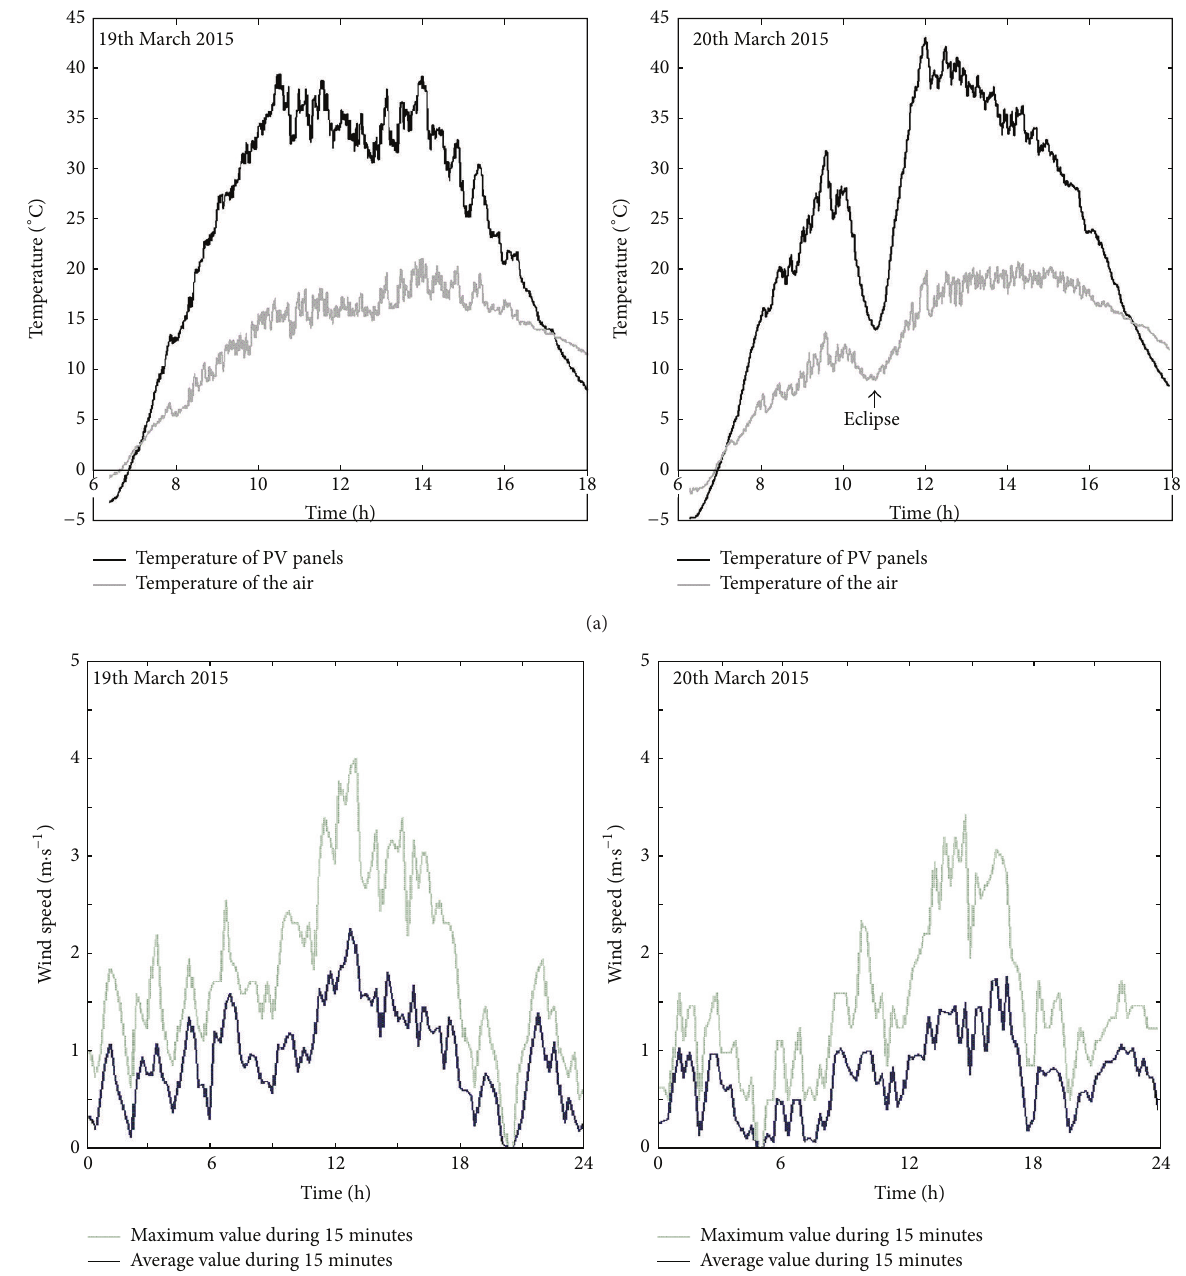
Figure 4: (a) Time series of PV panels temperature and air temperature and (b) time series of wind speed, during two sunny days (19th to 20th March